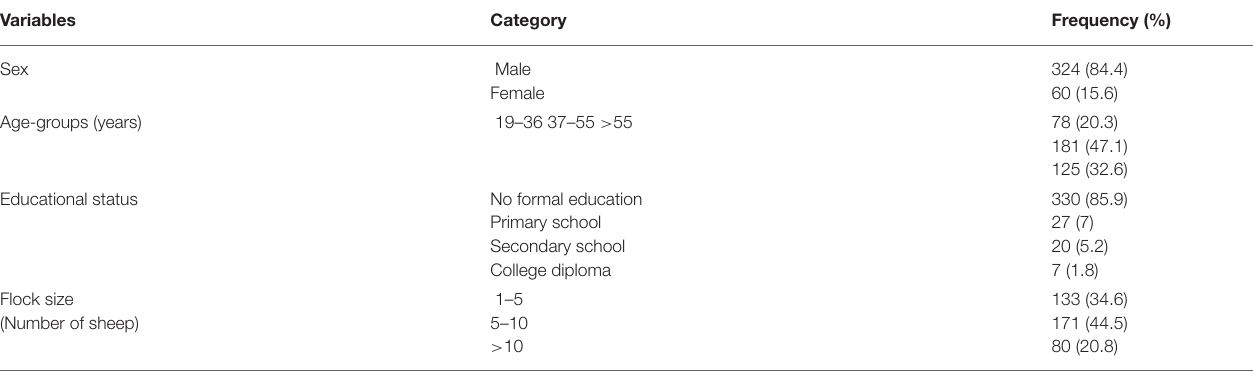
TABLE 6 | Socio-demographic characteristics of respondents ( n = 384).